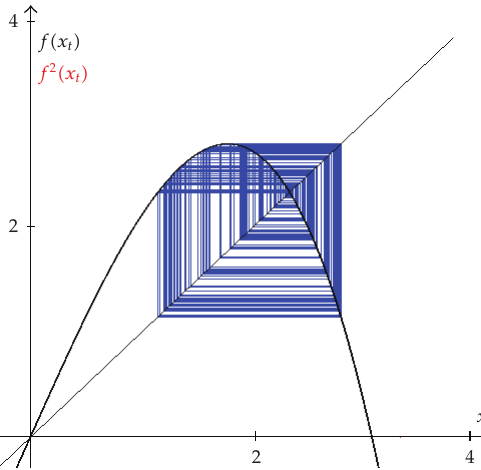
Figure 4: Homoclinic bifurcation of x (cid:7) . The two chaotic intervals around x (cid:7) merge into a unique chaotic interval for e (cid:4) 3 . 89. The remaining parameters are as in Figure